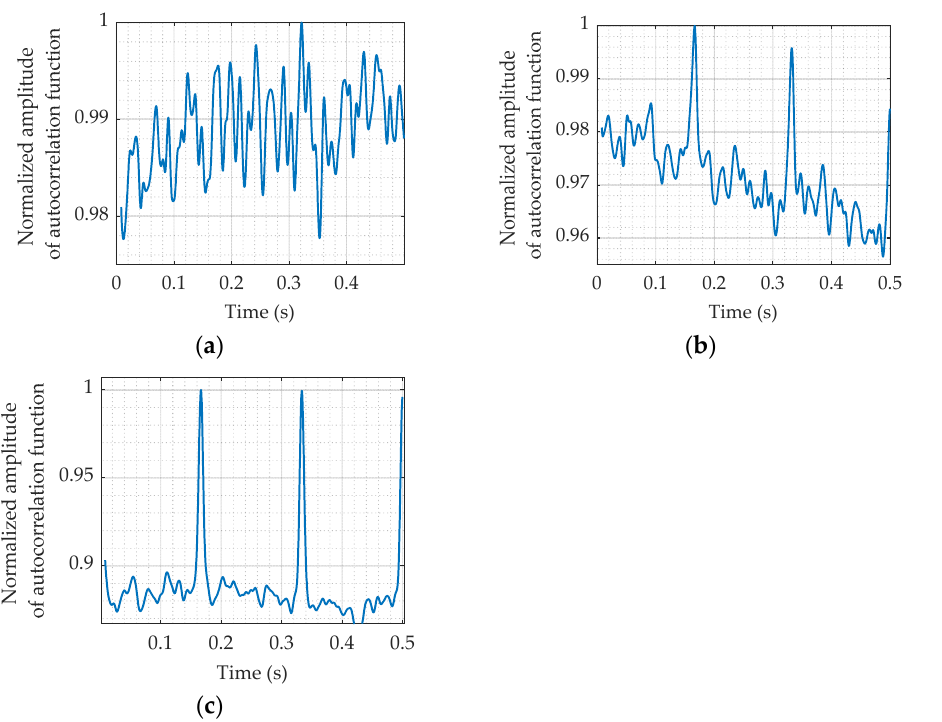
Figure 8. The autocorrelation function in different noise environments. The autocorrelation function when SNR is − 15 dB ( a ); The autocorrelation function when the SNR is − 10 dB ( b ); The autocorrela- tion function when SNR is − 5 dB ( c